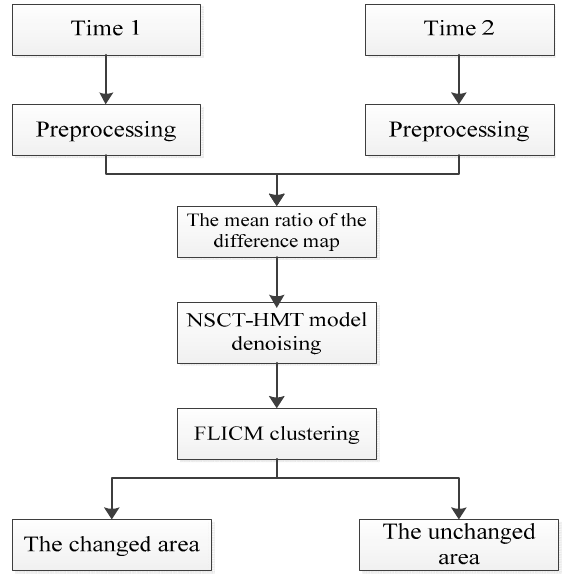
Figure 1. The algorithm flowchart.